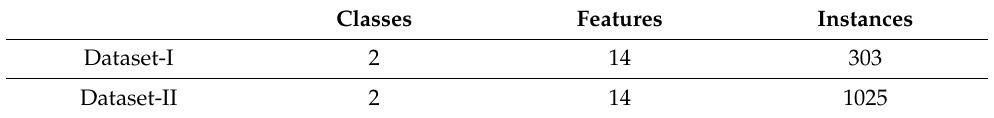
Table 1. Descriptions of the